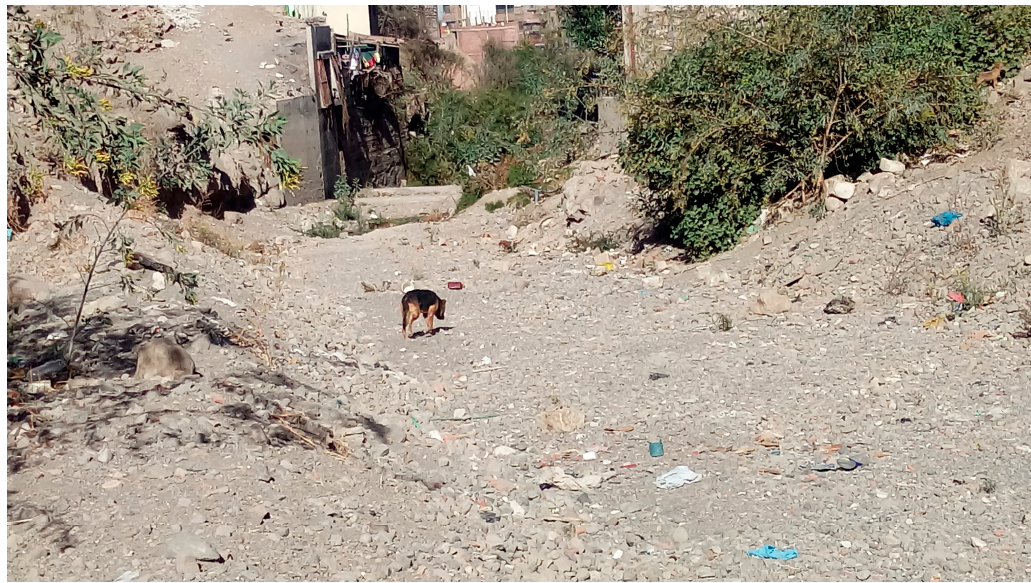
Figure 2. Dog in a dry water channel in the city of Arequipa.